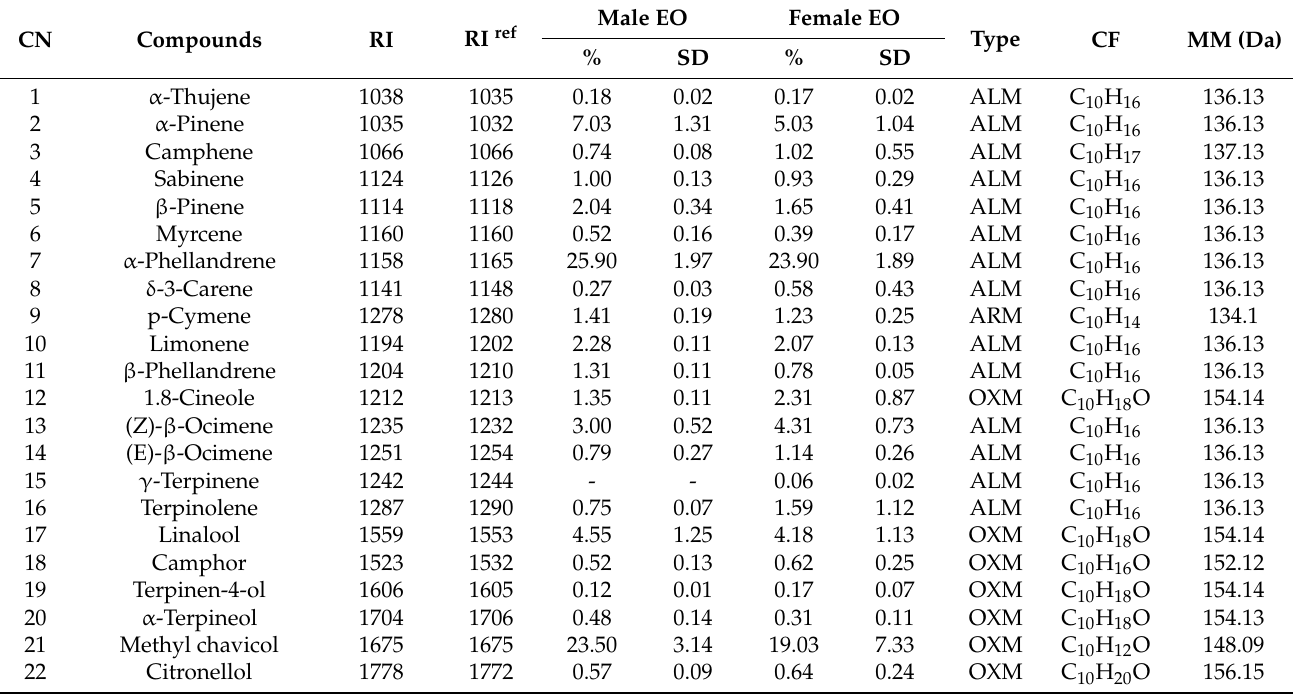
Figure 3. Compounds identified only in female Hedyosmum racemosum essential oil. The data of the chemical composition qualitative and quantitative of the male EO and female EO obtained using polar column HP-INNOWax are shown in Table 3. Forty-one compounds were identified in male EO, which represent 98.83% of the total composition, and forty-three compounds in female EO (99.62%). Table 3. Chemical compounds present in the essential oil of Hedyosmum racemosum leaves identified using the polar column